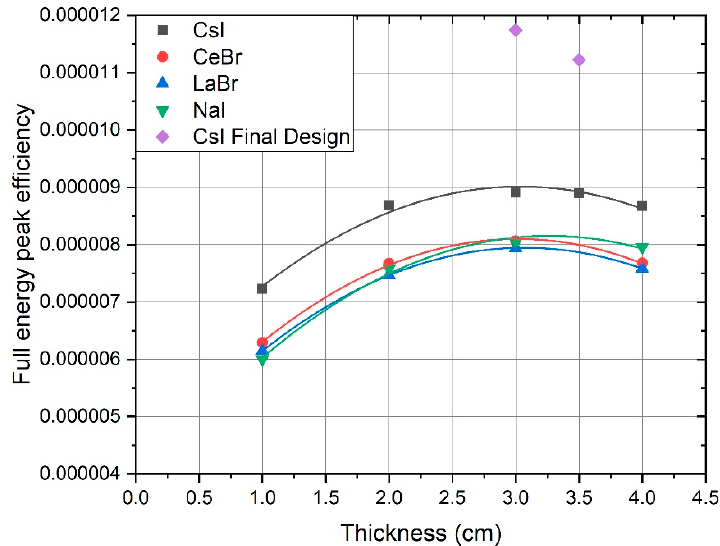
Figure 3. Results of Monte Carlo simulations using Penelope (2018). Different detector materials and geometries with a mass of 1 kg (all except Final Design) compared to the detector efficiency of the combination of the two main gamma peaks of Co-60 (1173 keV and 1332 keV).